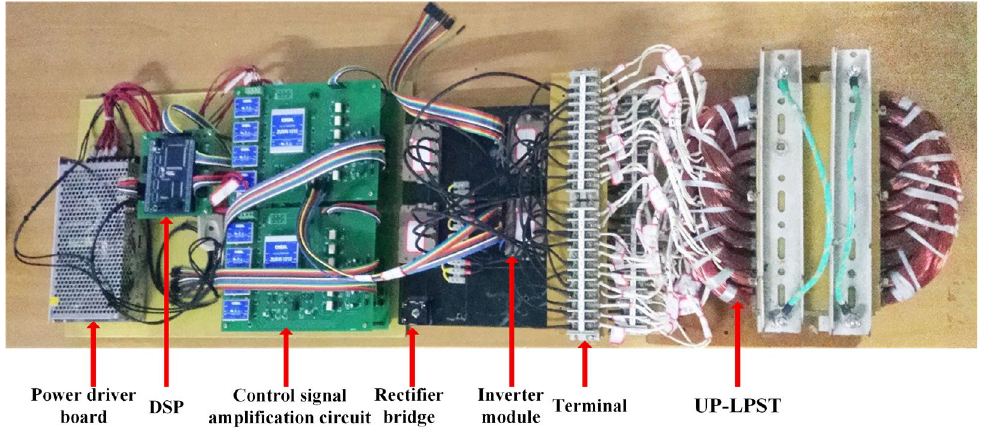
Figure 14. Experimental transformer.